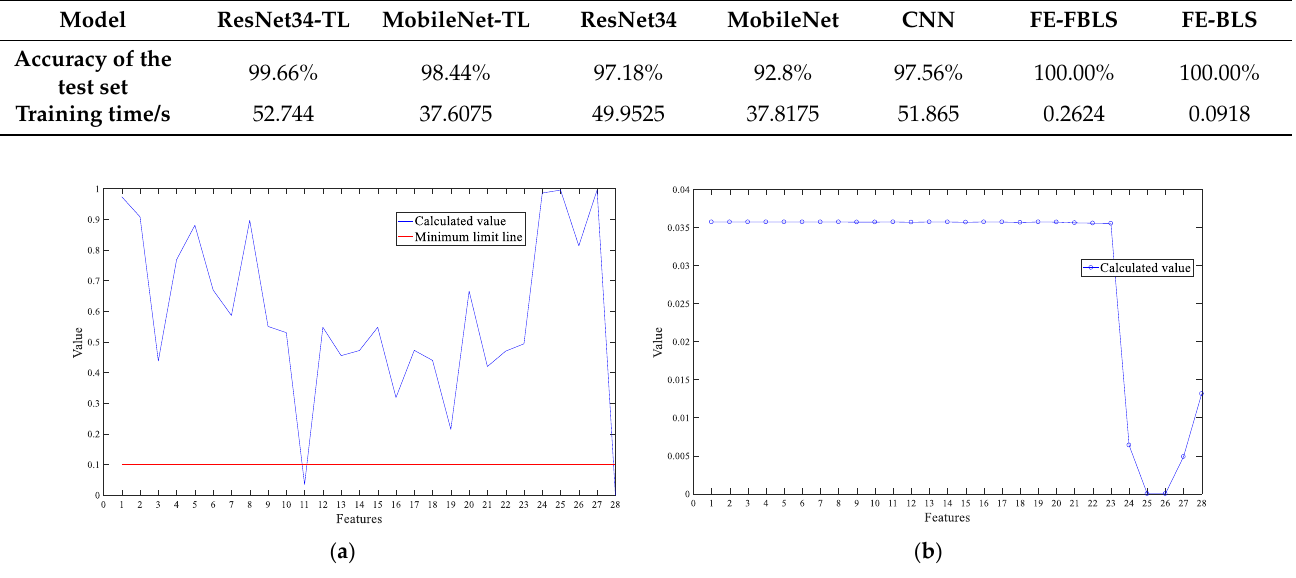
Figure 8. Value of each characteristic calculation index under Dataset 2: ( a ) Correlation; ( b ) ro- bustness.